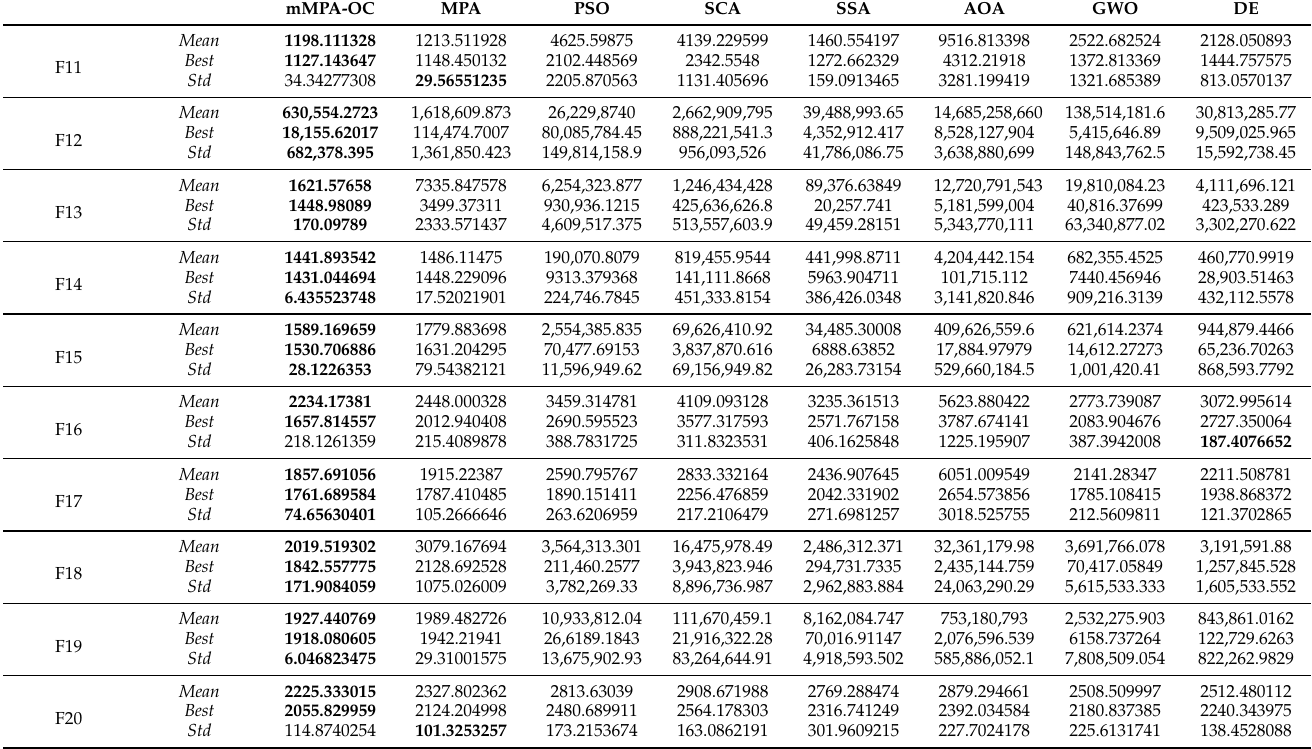
Table 11. Comparison of experimental results on CEC-2017 (30-dimensional) mixed